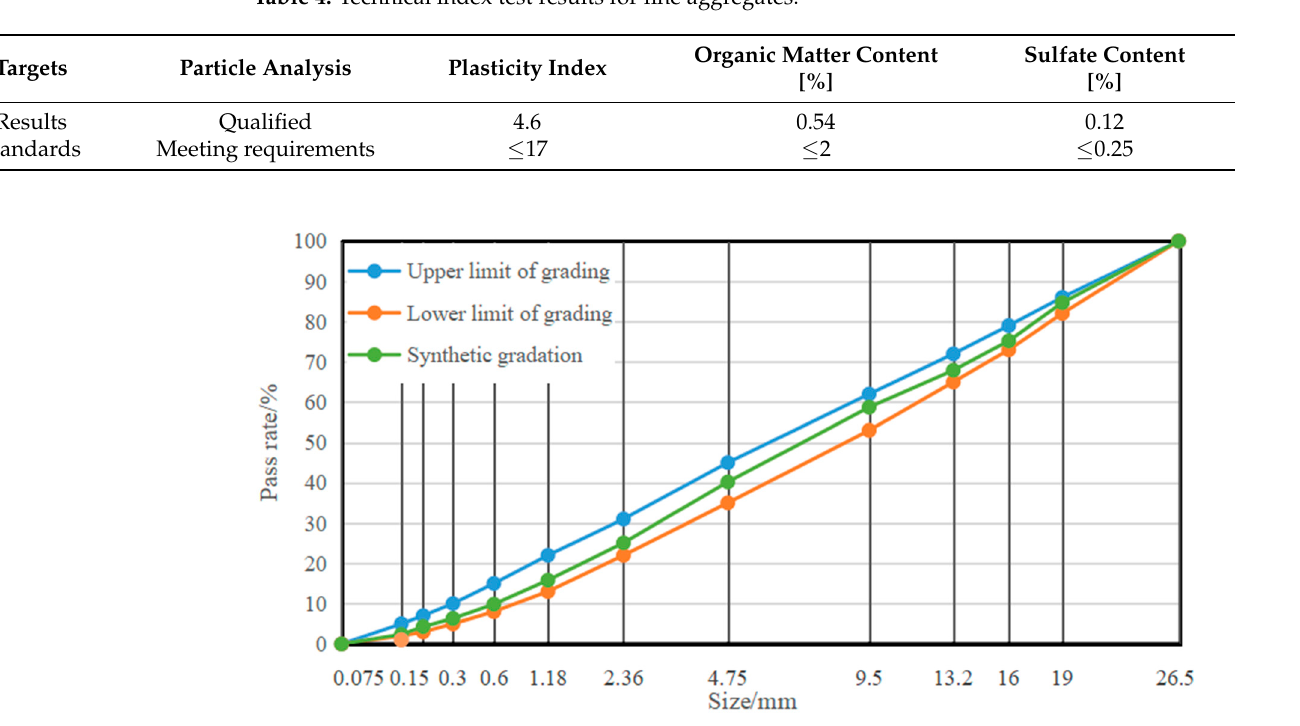
Table 3. Technical index test results for coarse aggregates.